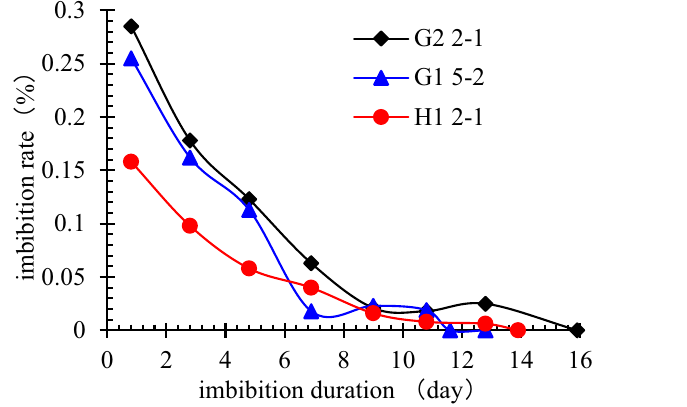
Figure 1. Imbibition velocity of different cores.